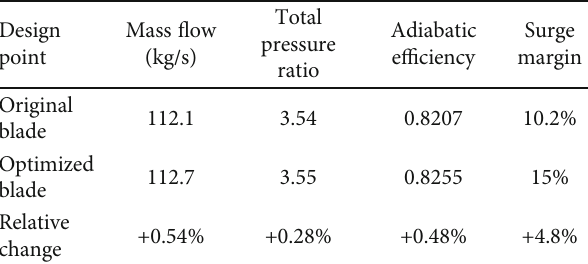
Table 3: Performance at the design point before and after optimization in the fi rst